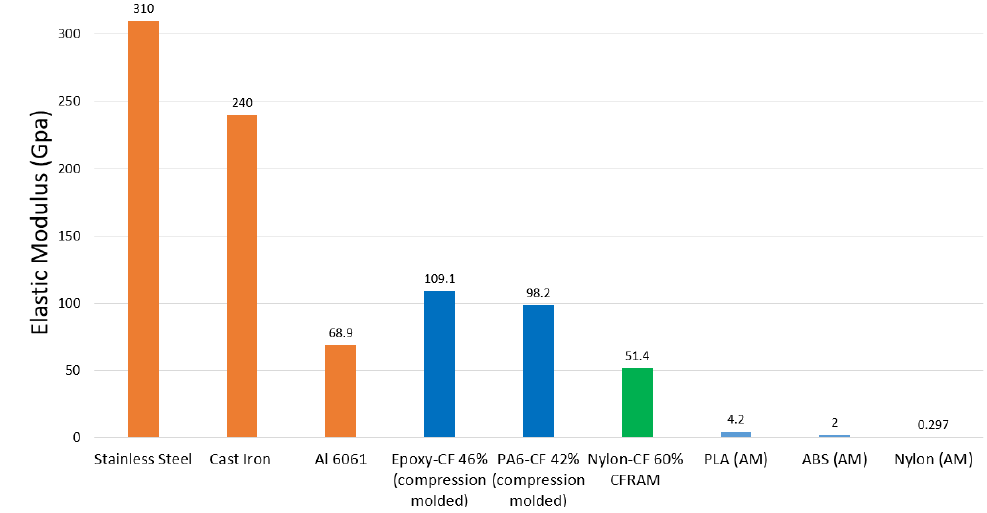
Figure 13. Comparison of elastic modulus of conventional materials used in manufacturing.